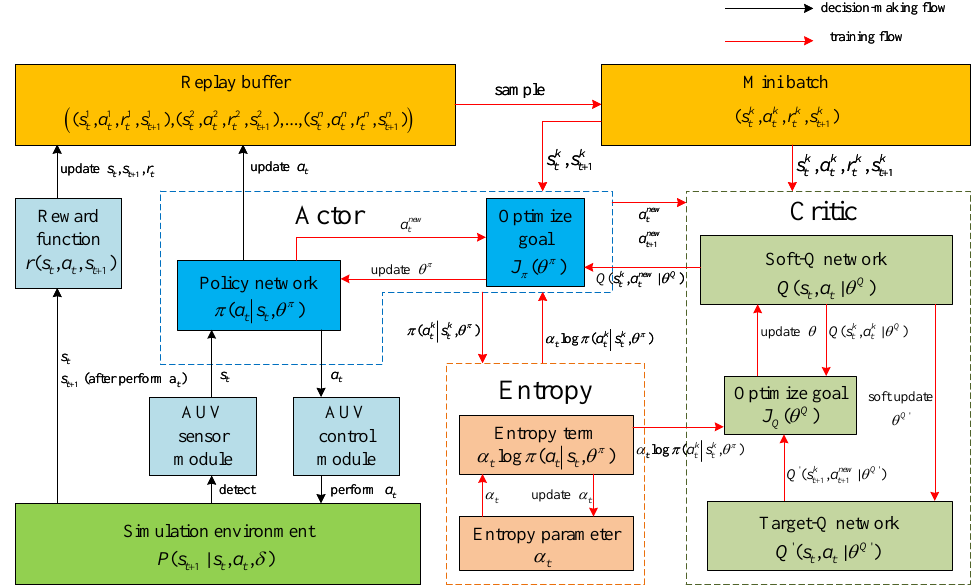
Figure 5. Decision agent update